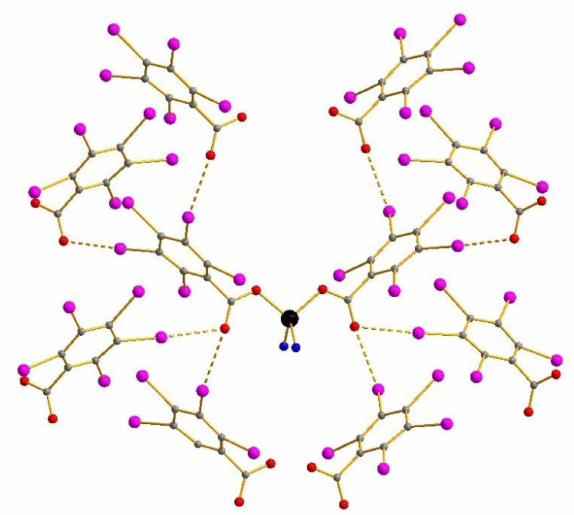
Figure 1. Structure of 1 (thermal ellipsoids, 50% probability). Here, and below: Zn—black, N—deep blue, C—grey, I—purple, O—red. H atoms are omitted for clarity.